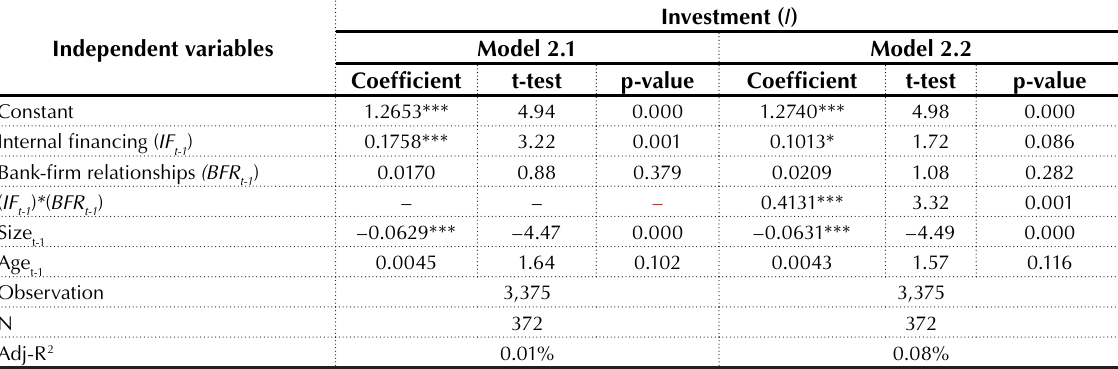
Table 3. Role of bank-firm relationships for the effect of internal financing on the investment Independent